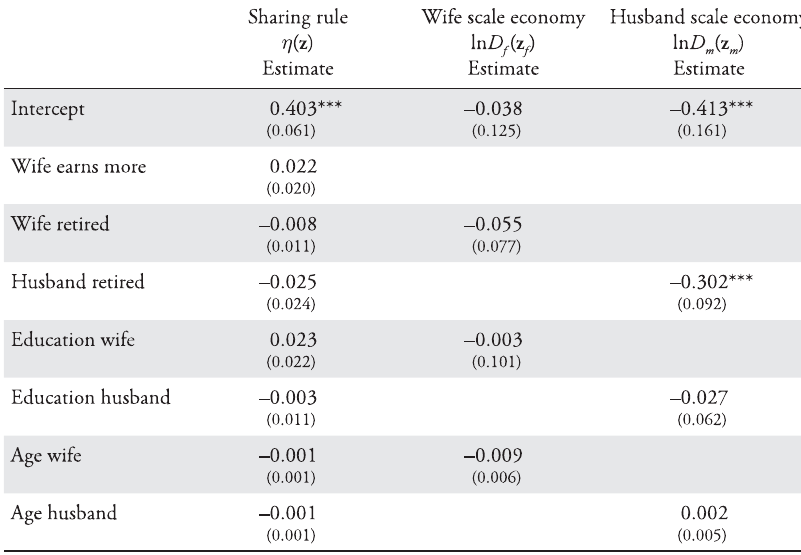
Table 9: Estimates Based on Data for Wtdows, Widowers, Singles, and Couples Sharing rule